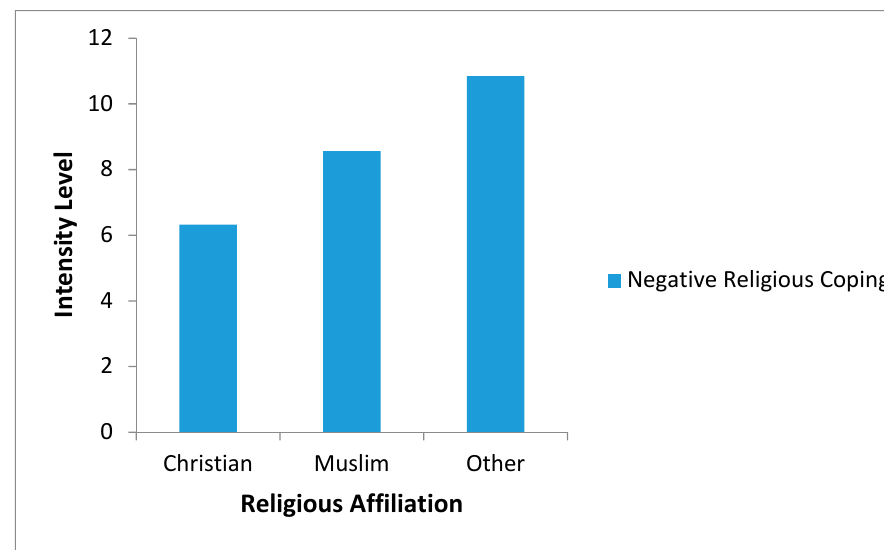
Figure 4. Student-athletes’ reported negative coping across religious affiliation.